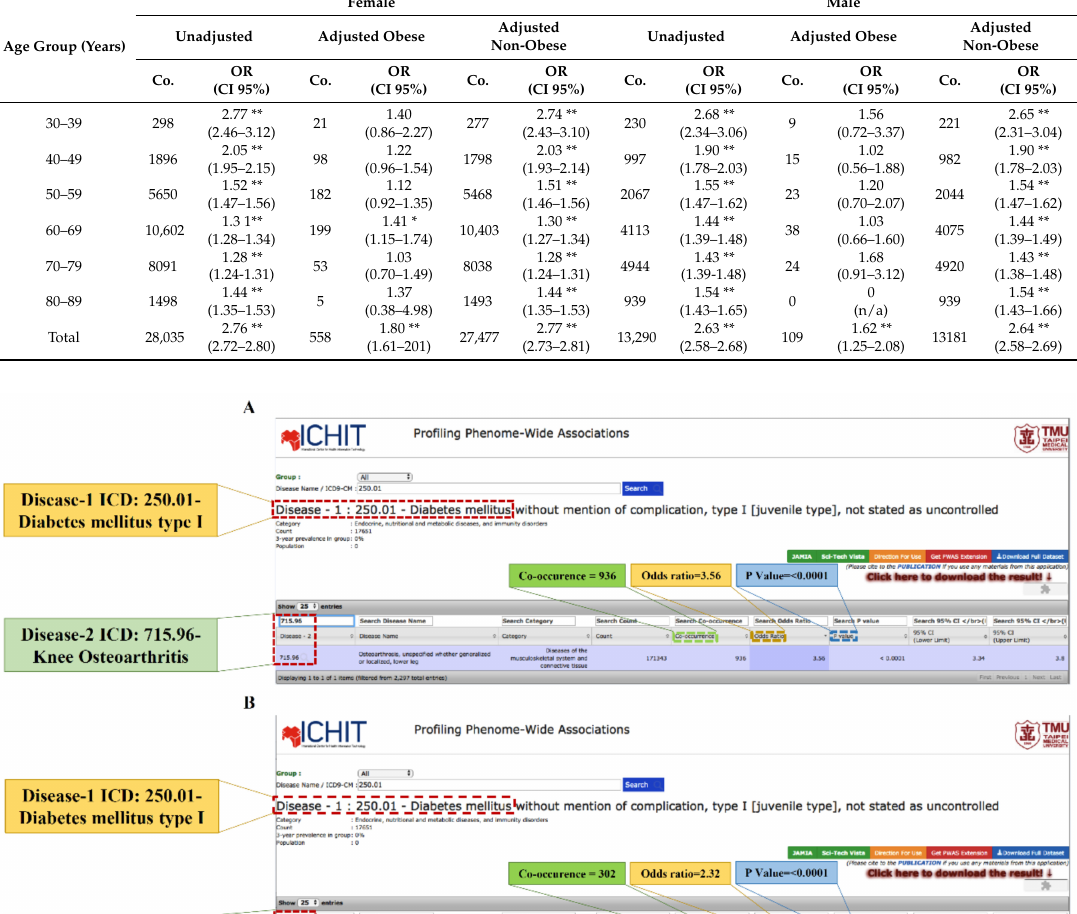
Table 3. The co-occurrence and odds ratio for association of T2DM with KOA observed among various age groups of both genders in the Taiwanese population (adjusted among obese and non-obese). Co.: co-occurrence, OR: odds ratio, n/a = not available. * and ** indicate p -value less than 0.05 and 0.0001, respectively.